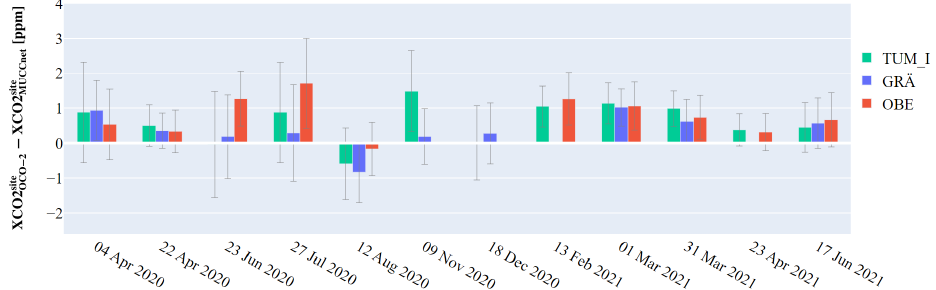
Figure 10. Daily offsets of collocated X CO captured by OCO-2 and MUCCnet in each comparison domain. During most overpasses the 2 by-site offsets are alike for all comparison domains. However, during some overpasses (e.g., 23 June, 27 July, 9 November) we observe a higher level of intra-day variation of the daily by-site offsets, which can impede the detection of urban gradients.